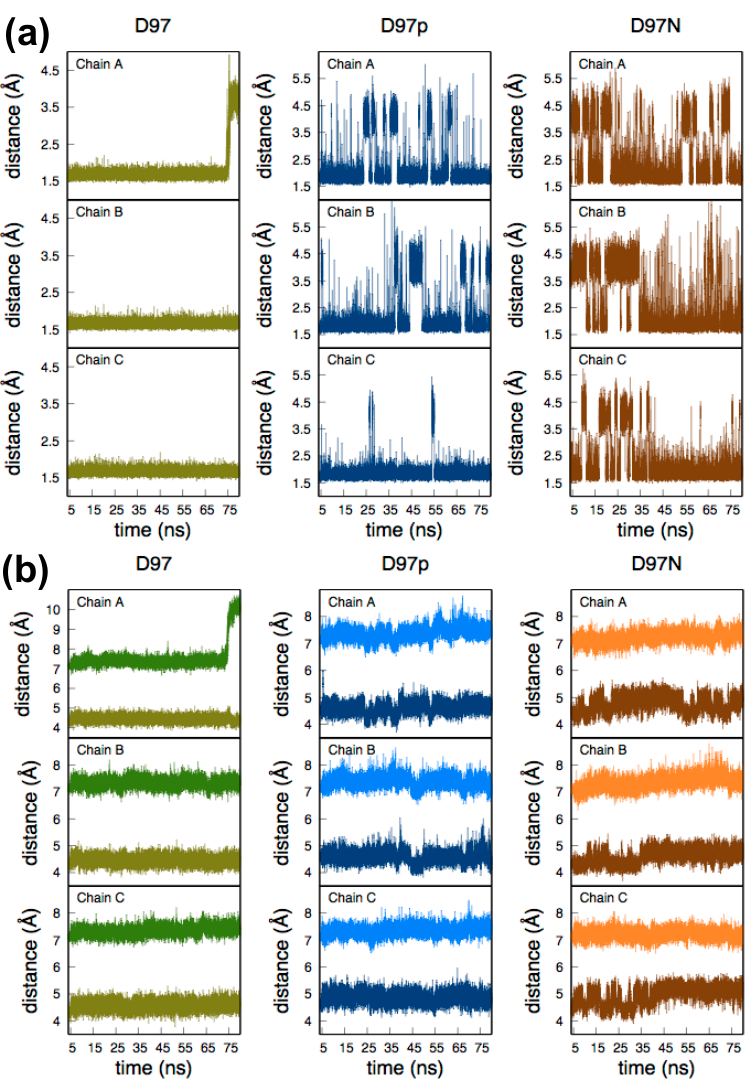
Figure 2. Relevant distances from 75 ns of MD trajectories for the three independent subunits (chains A, B and C) of Rp NiR, simulating deprotonated (D97) and protonated (D97p) active site Asp97 and the Asn97 mutant (D97N). ( a ) The distance between Tyr323-phenolic H to the nearest O of Asp97 (for D97 and D97p) and to O/N- of Asn97 (for D97N). ( b ) The distance between (i) the T2Cu ion and the centre of mass of the side chain of Asp97 (olive in left panel and dark blue in middle panel) and that of Asn97 (brown in right panel); (ii) the T2Cu ion and the centre of mass of the side chain of Tyr323 (green in left panel, light blue in middle panel and orange in right